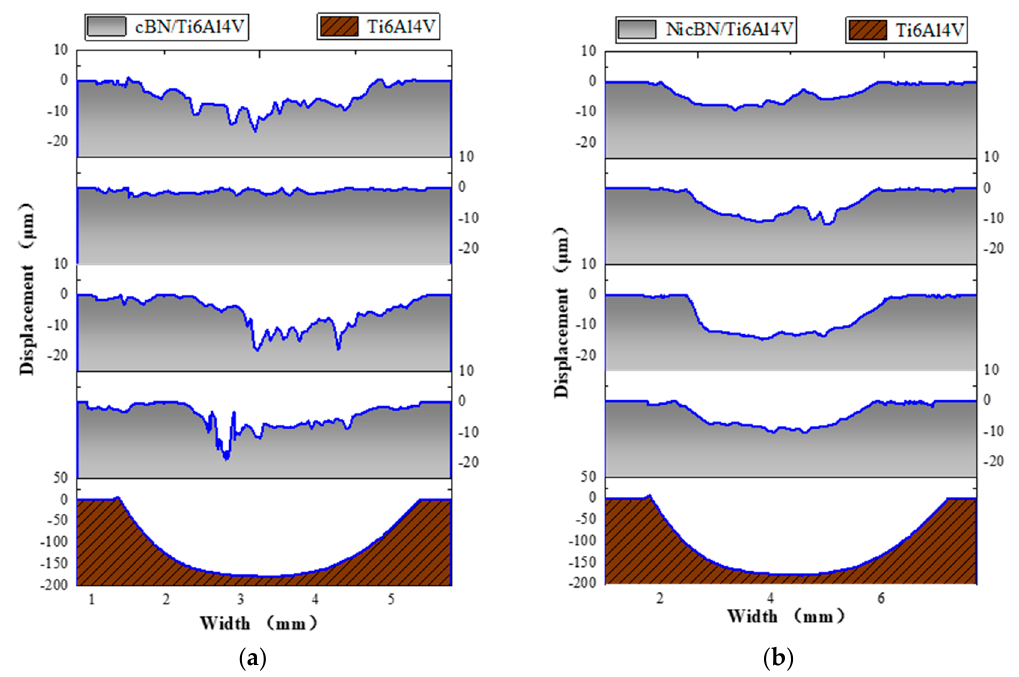
Figure 10. The profile curves of the worn cross-section: ( a ) The cBN/Ti6Al4V composite coating; ( b ) the NicBN/Ti6Al4V composite coating.